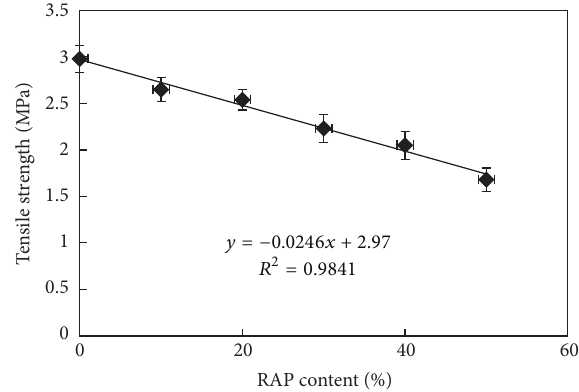
Figure 3: Tensile strength versus RAP content.